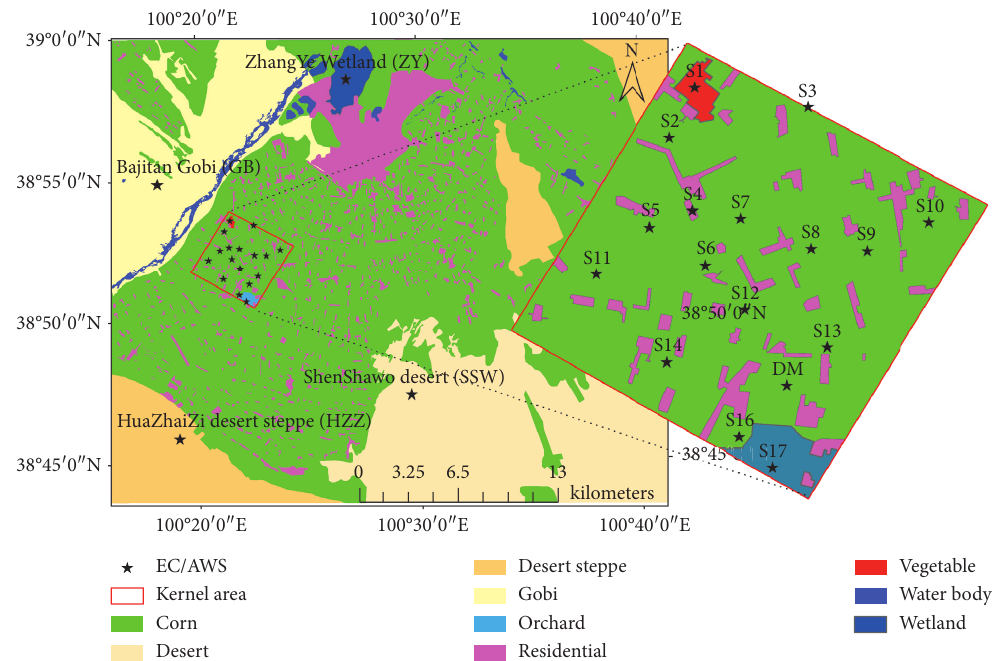
Figure 3: Land covers and observation sites in the research site.